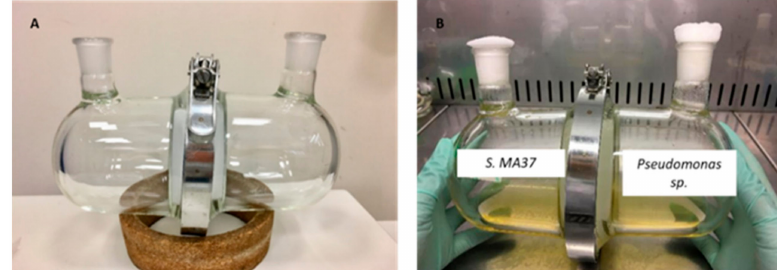
Figure 1. ( A ). Assembled co-culture device enabling separation of two independent cultures with a 0.22 µ m membrane filter and joined by a holding clamp. ( B ). Co-culture of Streptomyces sp. MA37 and Pseudomonas sp. prior to